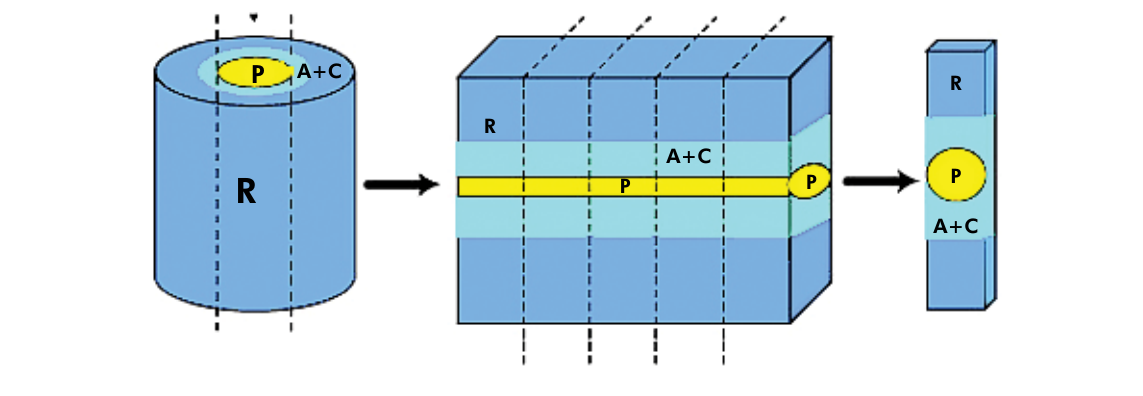
Figure 2. Schematic view of sample preparation in fiber post groups. R: Root, P: Post, A+C: Adhesive and